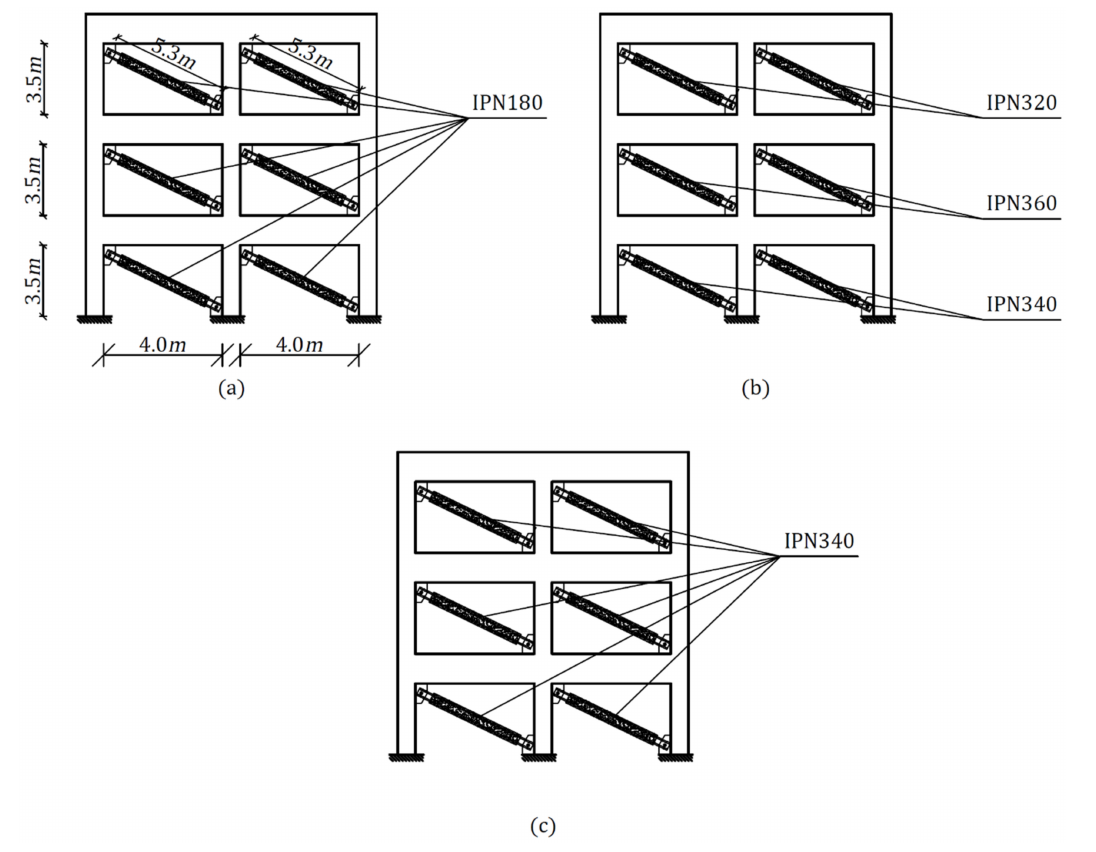
Figure 8. Three-story inelastic rigid frame system configurations: ( a ) initial BRBs allocation, ( b ) optimal BRBs allocation, and ( c ) equivalent uniform BRBs distribution.